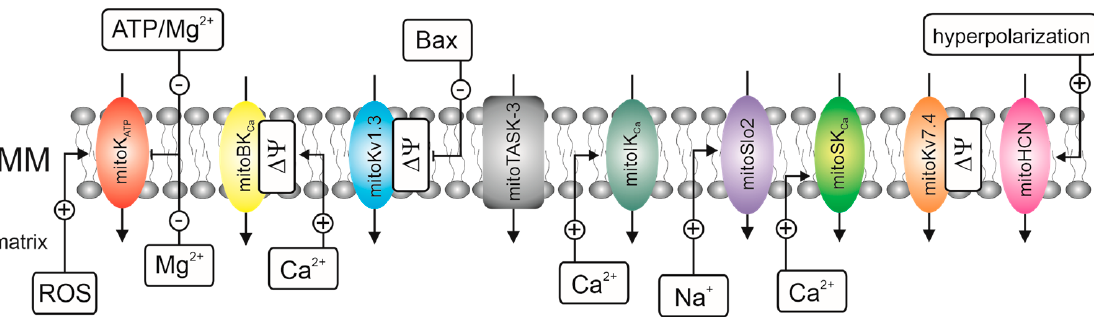
Figure 1. Potassium channels present in the inner mitochondrial membrane with their endogenous modulators. From the left: ATP-regulated (mitoK ATP ) channel, large-conductance Ca 2+ -regulated (mitoBK Ca ) channel, voltage-gated (mitoKv1.3) channel, two-pore domain (mitoTASK-3) channel, intermediate-conductance Ca 2+ -regulated (mitoIK Ca ) channel, large-conductance Na-regulated (mi- toSLO2) channel, small-conductance Ca 2+ -regulated (mitoSK Ca ) channel, voltage-gated (mitoKv7.4) channel, and hyperpolarization-activated and cyclic nucleotide-gated (mitoHCN) potassium channel. Based on biophysical and pharmacological properties, one could claim the similarity of the plasma membrane to mitochondrial potassium channels. In recent years, the molecular